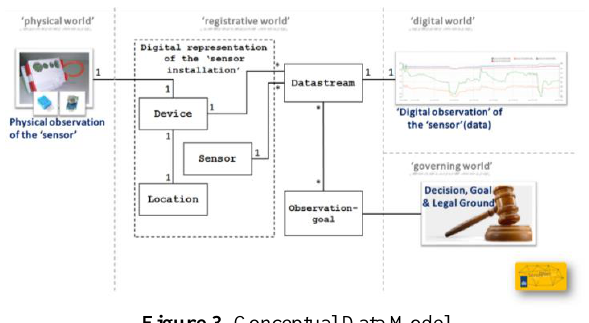
Figure 3. Conceptual Data